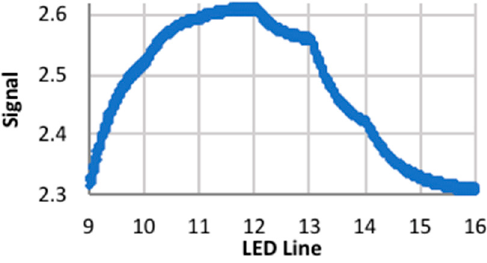
Figure 22. Peak signal (V) at 30 m—channel 5.